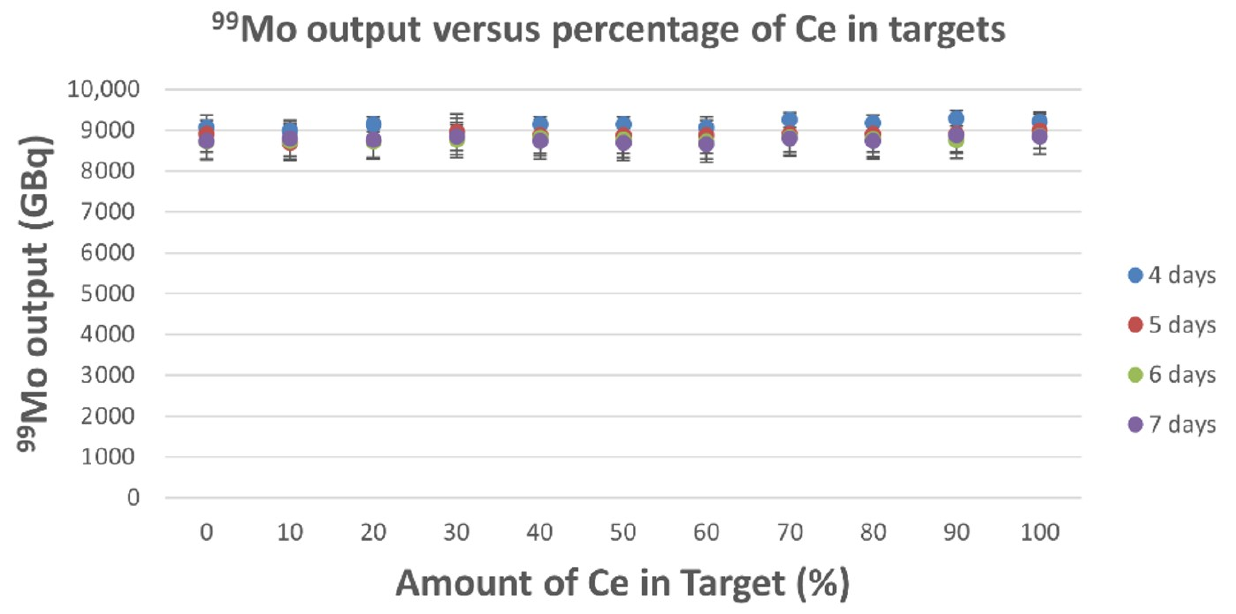
Figure 4. 99 Mo output of 4 target types with varying amount of Ce. The number of 100,000 GBq production runs to produce 10.4 kg 239 Pu for each of the four target types is plotted in Figure